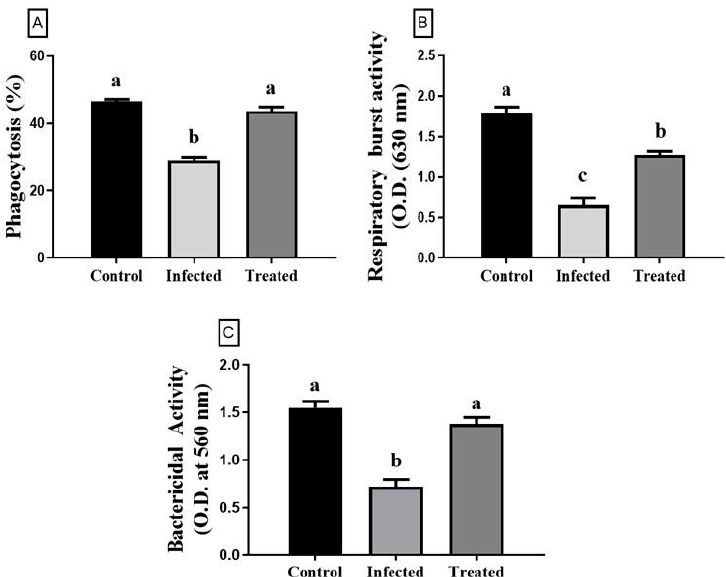
Figure 8. ( A ): Phagocytosis (%). ( B ): Respiratory bursts, and ( C ): Bactericidal activities of infected Litopenaeus vannamei with Vibrio spp. and those treated with florfenicol antibiotic. Values are expressed as the mean ± SME (n = 6 per group). Means with different superscripts are significantly different ( p < 0.05).